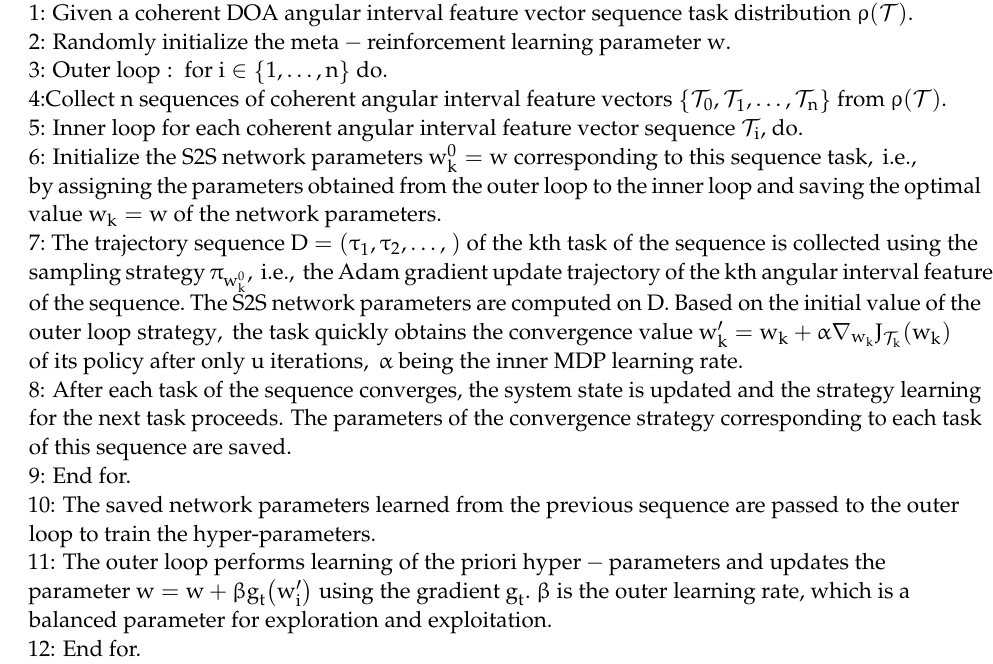
Algorithm 1 The Optimal Strategy Training Algorithm Based on Meta − reinforcement